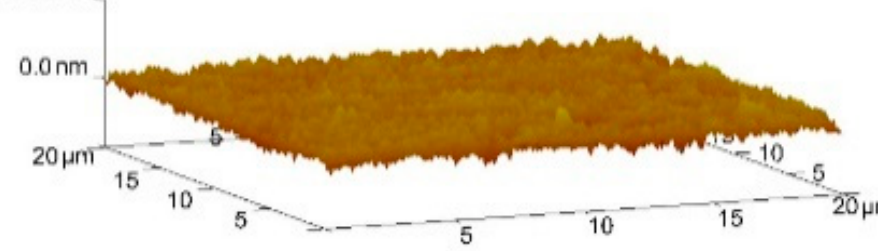
Figure 4. Topography AFM analysis of the coating.